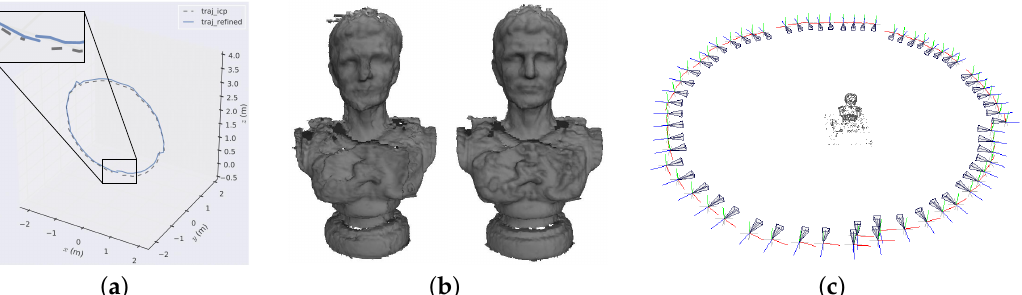
Figure 19. ( a ) shows the estimated camera trajectories before and after refinement, as well as the closeup view of the start and end segments. ( b ) demonstrates 3D models through volumetric integration of depth images, based on ICP-estimated poses (left) and refined poses (right) respectively. The reconstructed sparse point cloud along with the refined cameras is visualized in ( c